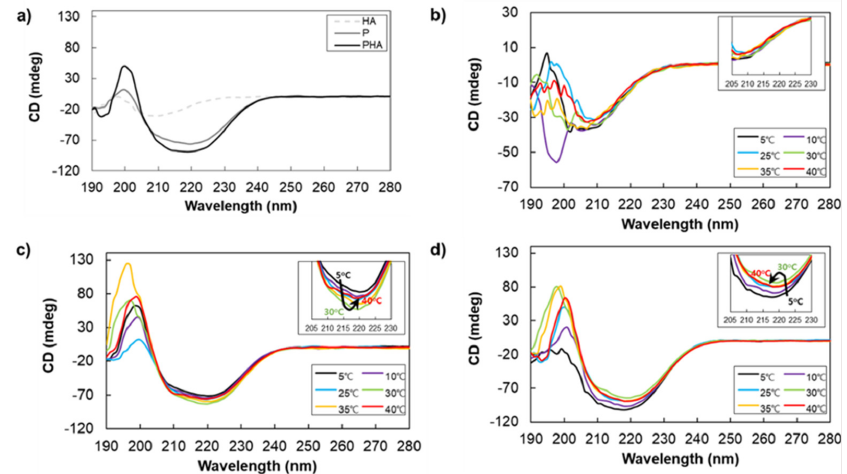
Figure 3. ( a ) The mean residue ellipticity of HA, P, and PHA aqueous solution (0.0125 wt.%) at 25 ◦ C and CD spectra of ( b ) HA, ( c ) P, and ( d ) PHA according to temperature from 5 ◦ C to 40 ◦